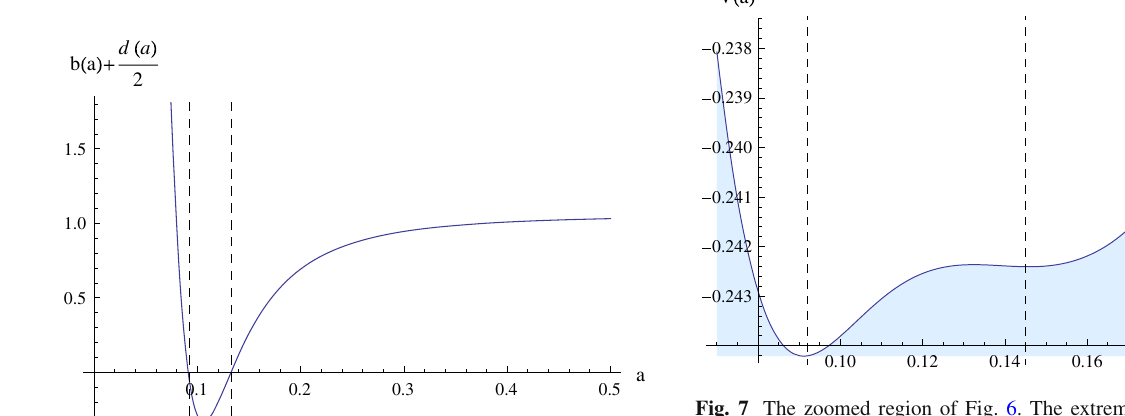
Fig. 7 The zoomed region of Fig. 6. The extrema of V ( a ) are pre- sented. The black dashed lines represent the freeze singularities. The potential V ( a ) is expressed in units of 10 4 km 2 s 2 Mpc 2 (cid:11) − (cid:11) δ (cid:11) 3 = (cid:11) + 4 (cid:11) (cid:4) , (17) R m R where (cid:11) γ = 3 γ H 2 and (cid:11) δ = 9 δ H 4 0 0